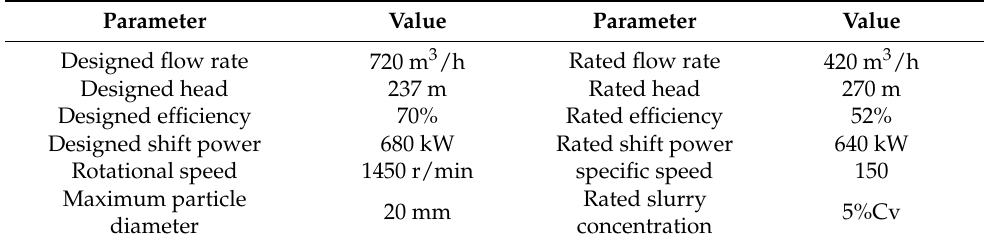
Table 1. Six-stage centrifugal pump design parameters.